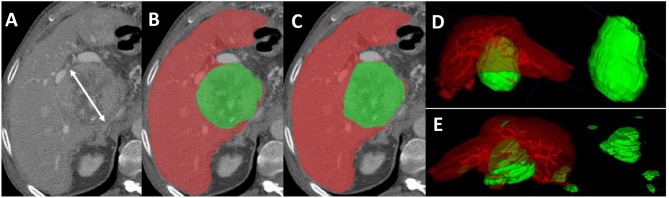
Axial sections from a pre-TACE abdominal CT scan of a 64-year old male patient with advanced HCC. (A) Shows an 8.5 cm lesion measured with mRECIST criteria. (B) Shows the manual segmentation of the hepatic parenchyma (red) and the HCC tissue (green); the tumor volume, measured with M-vRECIST, was 377.25 cm3. (C) Shows the automated segmentation of the parenchyma (red) and HCC tissue (green); the tumor volume measured with A-vRECIST was 187.9 cm3. (D,E) Show the 3-dimensional voxel rendering according to M-vRECIST and A-vRECIST, respectively. A-vRECIST, automated volumetric response evaluation criteria in solid tumors; CT, computed tomography; HCC, hepatocellular carcinoma; mRECIST, modified response evaluation criteria in solid tumors; M-vRECIST, manual volumetric response evaluation criteria in solid tumors; RECIST, response evaluation criteria in solid tumors; TACE, transarterial chemo embolization.